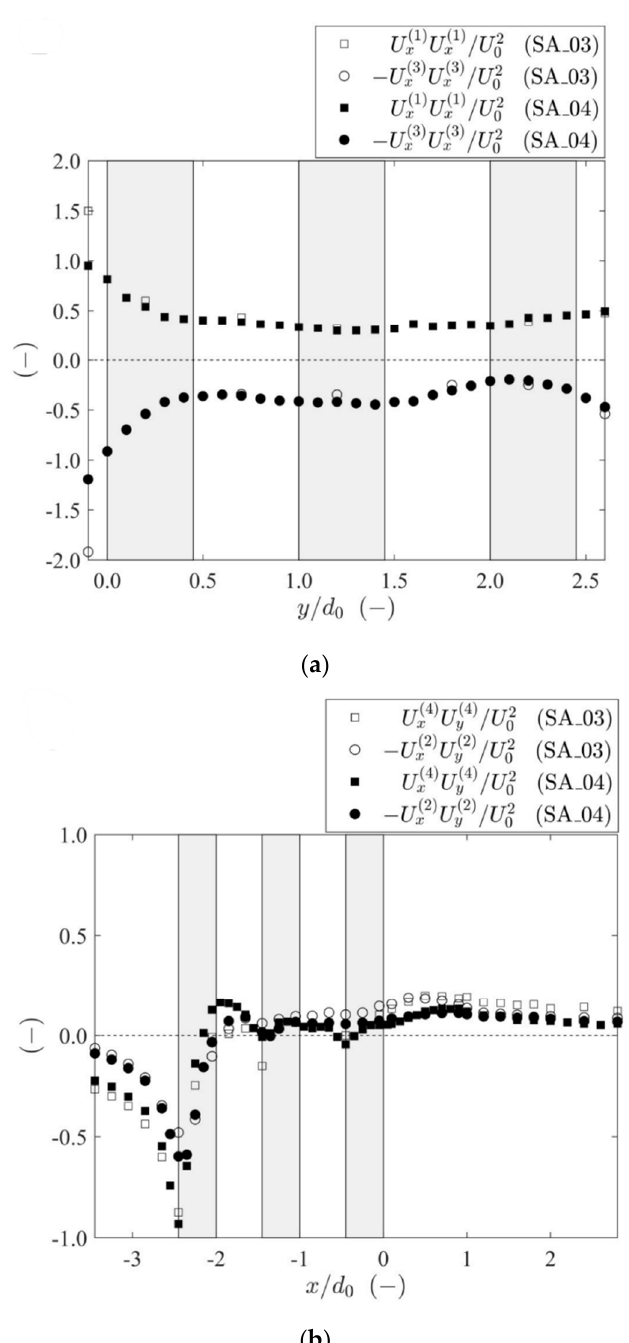
Figure 5. Distribution of convective transport on ( a ) S 1 , S 3 and ( b ) S 2 , S 4 .